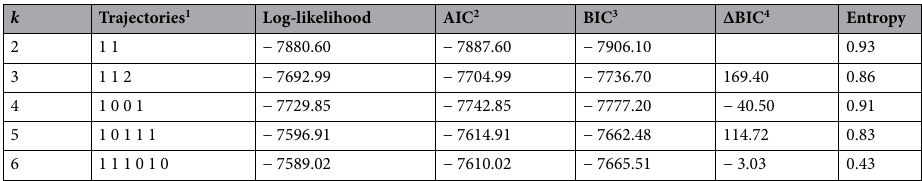
Table 1. GBTM fit statistics for two to six group models. k = Number of groups. 1 Listed as order of powers (0 = intercept, 1 = linear, 2 = quadratic). 2 AIC: Akaike Information Criterion. 3 BIC: Bayesian Information Criterion. 4 ΔBIC: Difference in BIC from previous model ( k